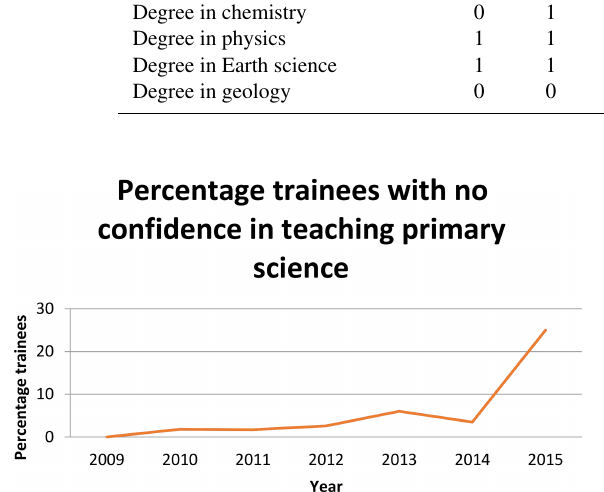
Figure 3. Percentage of teacher trainee participants at ESEU work- shops stating they had no confidence in teaching primary science prior to participating in the